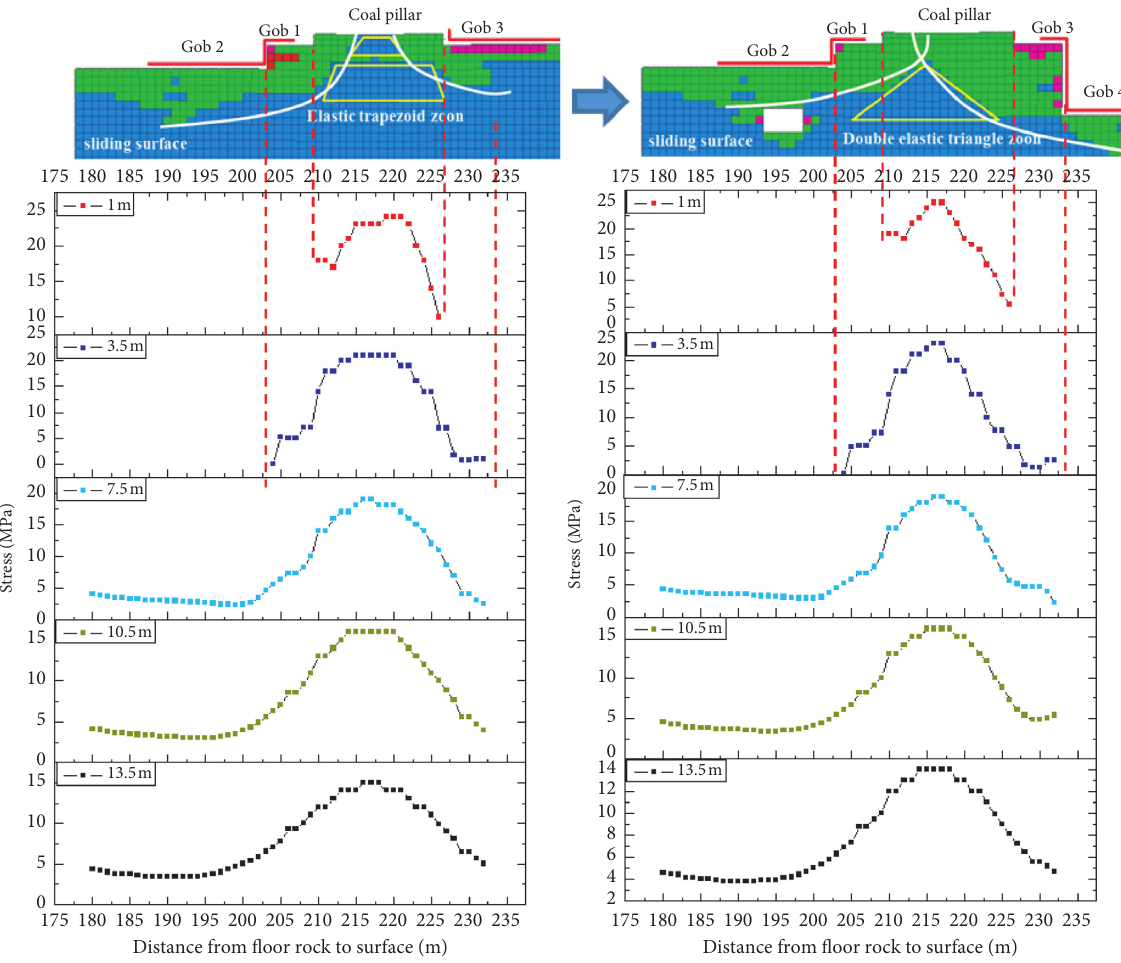
Figure 17: Stepped coal pillars in close coal